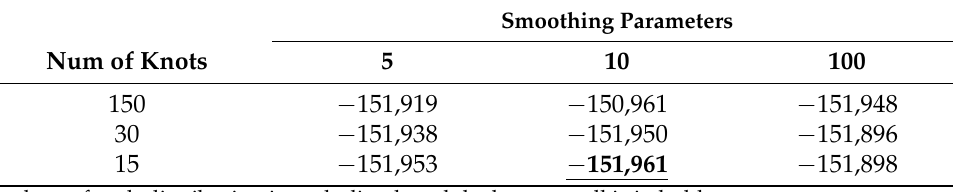
Table 5. DIC for Gamma distribution (23 June 2016, TMC, Aichi, Japan).